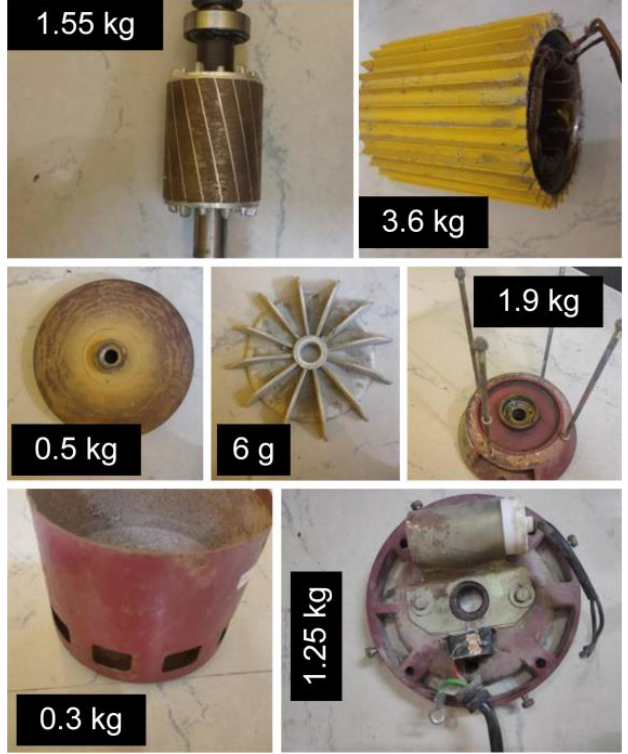
Figure 2. Weights of various parts of the motor.